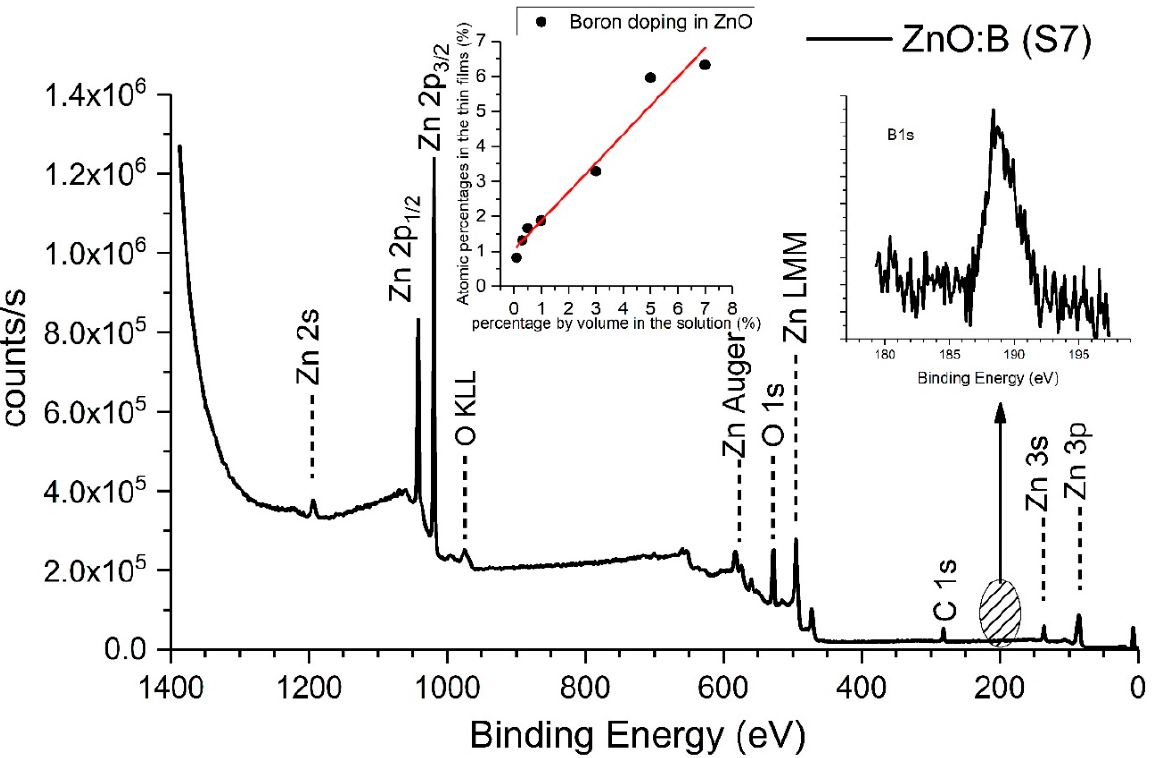
Figure 3. A representative XPS survey spectrum of the boron-doped ZnO thin films. The inset shows ( left ) the actual dopings obtained from the XPS and the nominal values and ( right ) a magnification of the spectrum with the B 1 s peak.